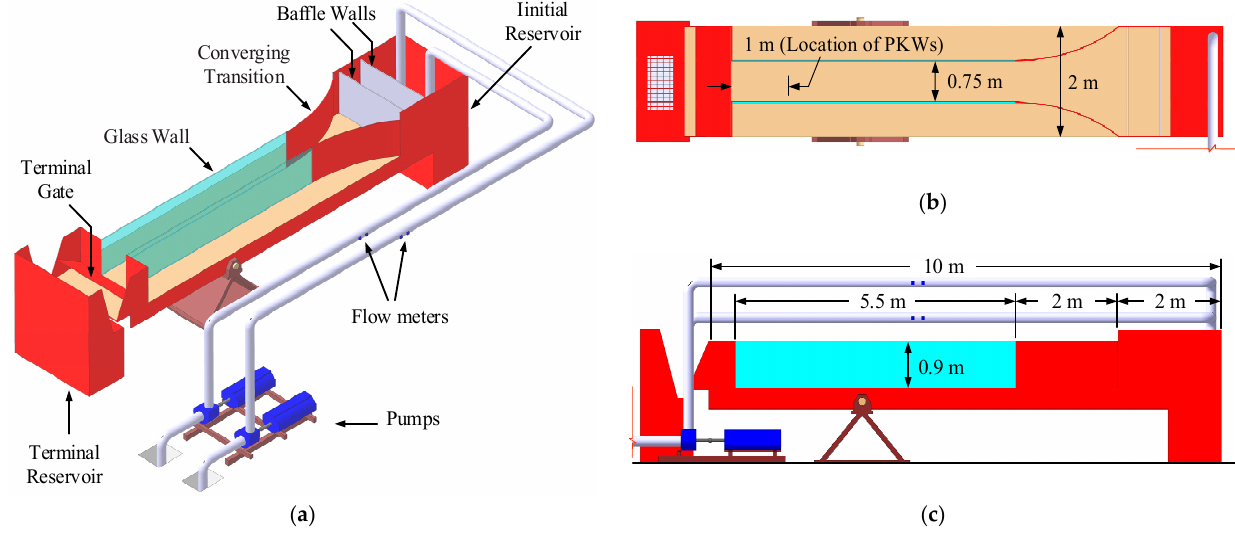
Figure 2. Overview of implemented test facilities: ( a ) the 3D view from downstream; ( b ) the plan view; ( c ) the side view.